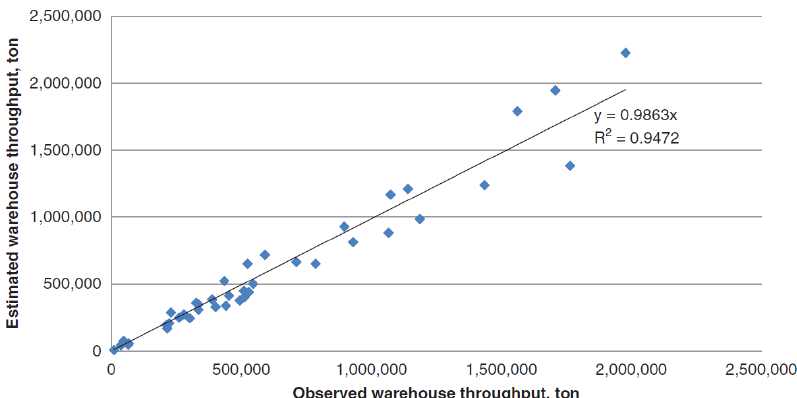
Figure 3. Comparison of estimated and observed warehouse flows per region The model calibration has been performed according to equation (16), minimizing differences between observed and estimated flow. In the calibration, the following model parameters were